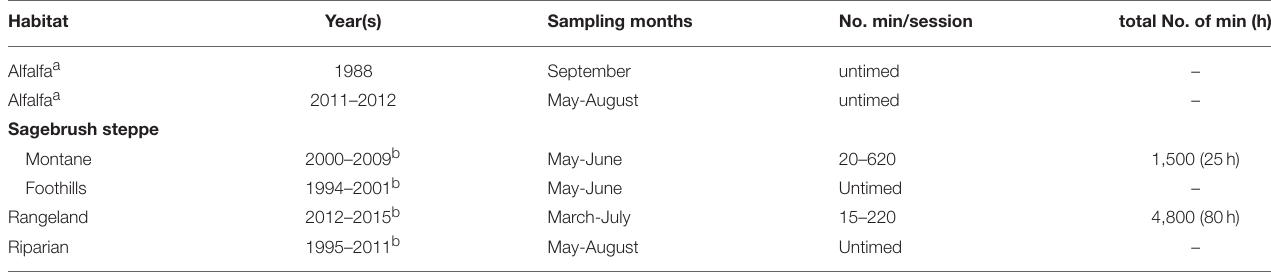
TABLE 2 | Summary of sampling by visual searching in various habitats in 1988–2015, from which the numbers of individuals of adult lady beetles ( Coccinella spp.) encountered were determined. Habitat Year(s) Sampling months No. min/session total No. of min